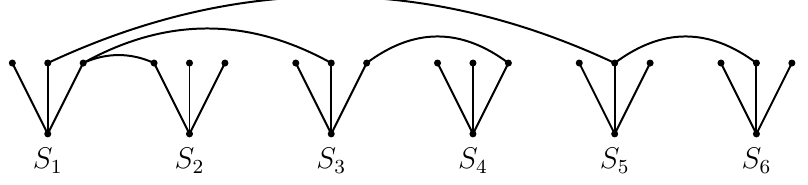
Figure 2: An illustration of a k -special tree with k = 3 and t = 6